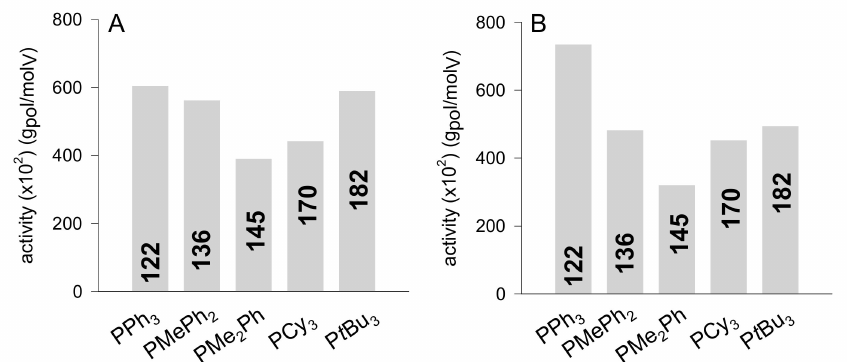
1 Polymerization conditions: ethylene pressure, 1.01 bar; total volume, 25 mL (toluene); V-complex, 5 µ mol; Al / V = 500; ETA / V = 50; temperature, 22 ◦ C; time, 2 min; 2 measure of the electron-donating properties of phosphine ligands, as reported by Tolman [35]; 3 phosphine cone angle, as reported by Tolman [35]; 4 activity in g pol / mol V ; 5 determined by size-exclusion chromatography (SEC).